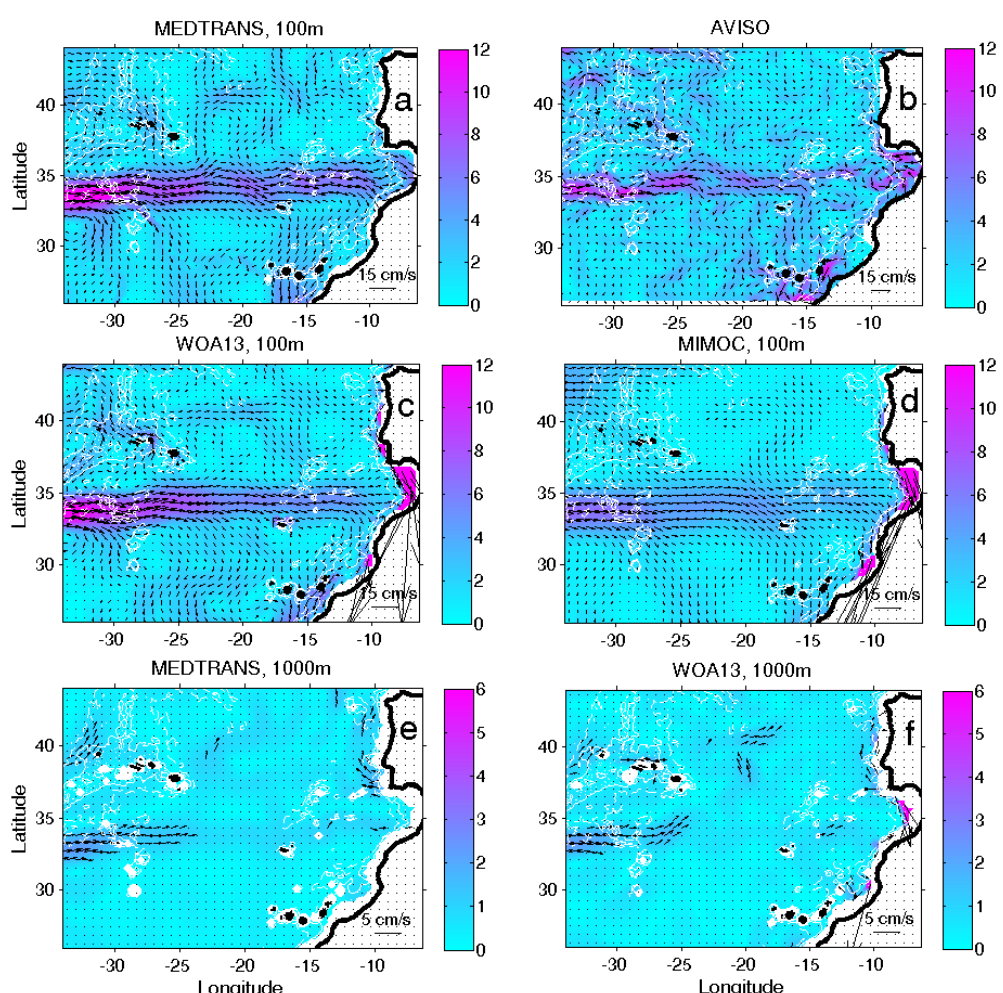
Figure 11. Velocity of geostrophic currents (cms − 1 ) at 100m referenced to 1900m, derived from (a) MEDTRANS, (c) WOA13 and (d) MIMOC. AVISO surface currents, averaged between 1992 and 2012, are presented in (b) . Velocity of geostrophic currents at 1000m referenced to 1900m (cms − 1 ), derived from (e) MEDTRANS and (f) WOA13. Velocity vectors are overlaid. For reference, 2000m and 3000m depth contours are shown in